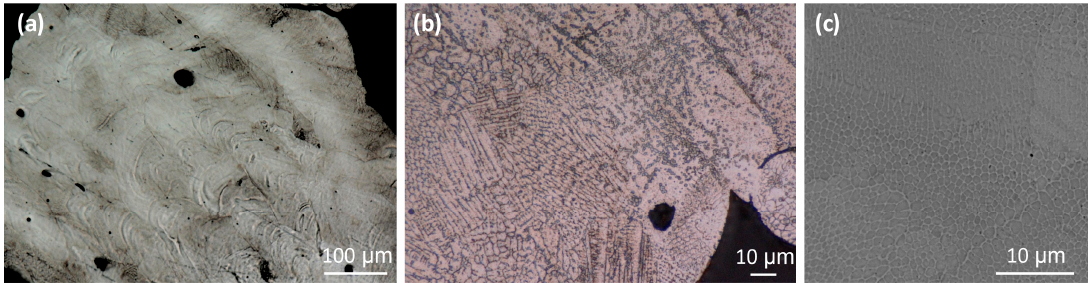
Figure 8. Optical ( a , b ) and SEM ( c ) images of the microstructure of SLM structures revealing the characteristic morphology of laser-melted techniques, i.e., equiaxed austenitic grains.